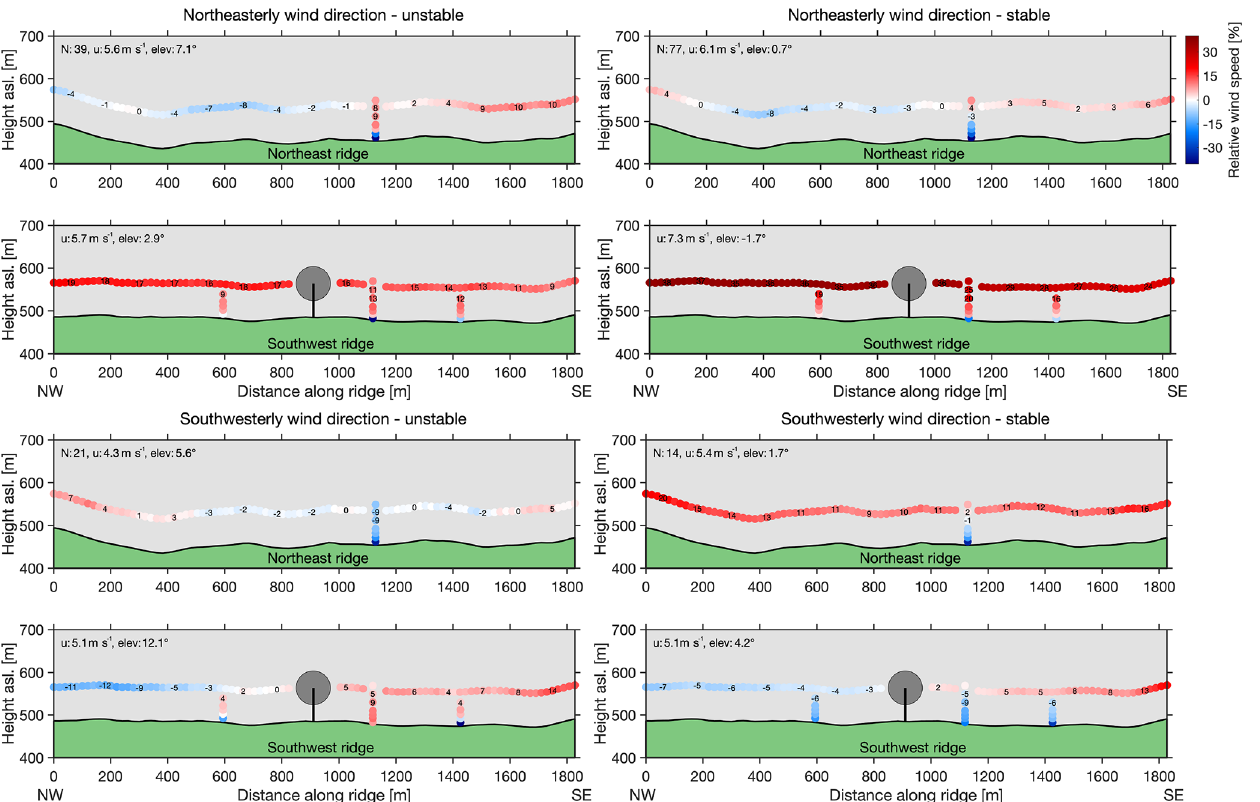
Figure 5. Normalized wind speeds measured by the lidars and sonics during different atmospheric conditions. The wind speeds are normal- ized by the mean along the upstream ridge; e.g., for southwesterly wind directions all measurements are normalized with the mean wind speed along the SW ridge. N is the number of 10min periods; u is the horizontal wind speed measured by the 80m sonic anemometer; “elev” is the flow elevation angle measured by the 80m sonic anemometer.